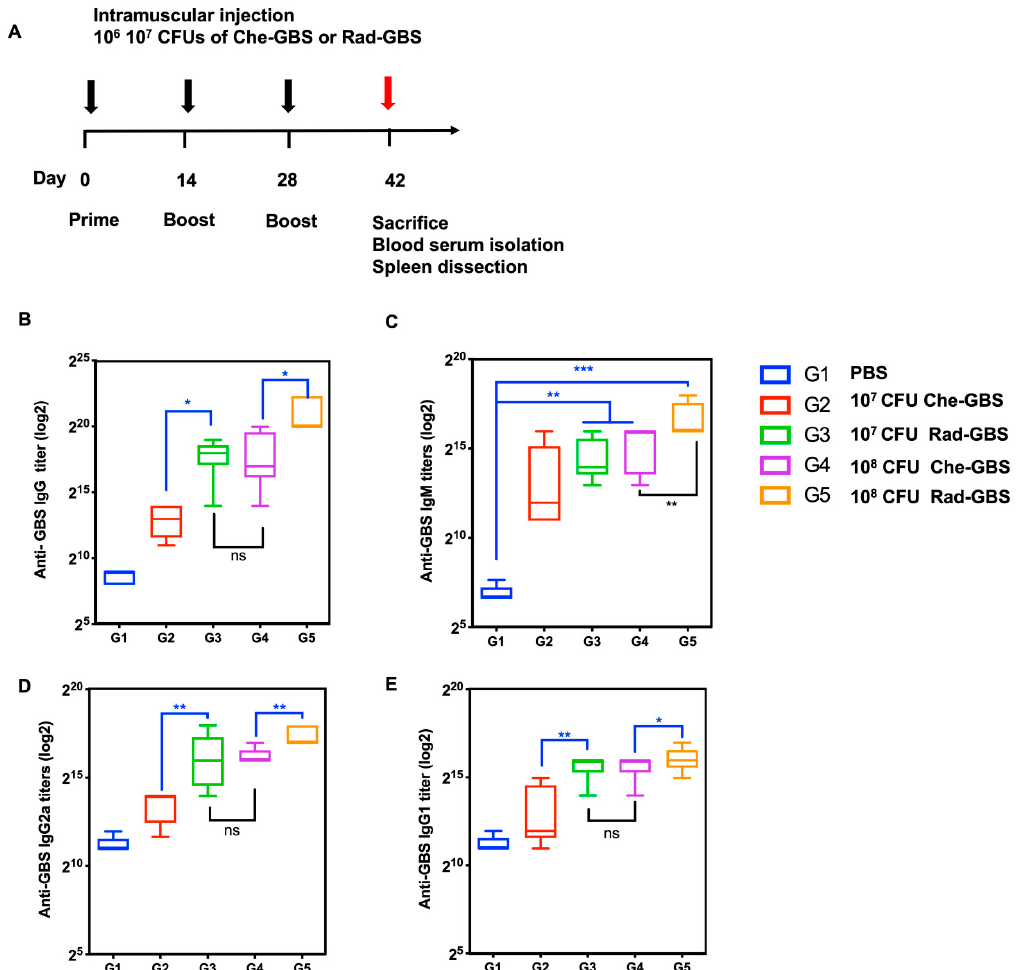
Figure 3. Immunoglobulin titers in sera from mice vaccinated with various dosages of Rad-GBS or Che-GBS. ( A ) Mice ( n = 5) were vaccinated with 10 7 or 10 8 CFU of Rad-GBS or Che-GBS intramus- cularly at two-week intervals, as in the schedule shown, and the mice were immunized with PBS as the control group. Serum levels of GBS-specific immunoglobulin G (IgG). ( B ) and immunoglobulin M (IgM) ( C ) were isolated and analyzed 7 days after the last immunization. The antibody levels of subclasses of IgG, such as ( D ) IgG1 and ( E ) IgG2a, were further determined. All data are expressed as the mean ± standard deviation of five mouse serum samples and three independent experiments. *** Stands for p < 0.001, ** stands for p < 0.01, * stands for p < 0.05, and NS for not